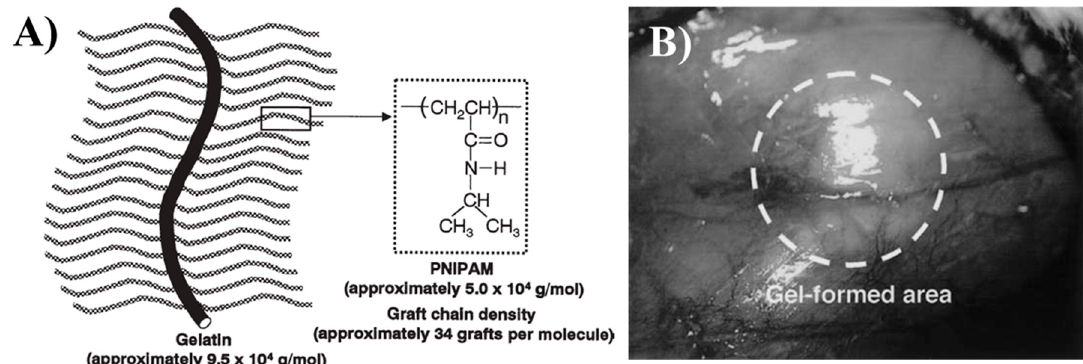
Figure 7. ( A ) Representation of the structure of poly( N -isopropylacrylamide)-grafted gelatin (PNIPAAm–gelatin) and ( B ) PNIPAAm–gelatin gel formation in rat subcutaneous tissue. Reprinted from reference [83]. Copyright © 2004 The Japanese Society for Artificial Organs.